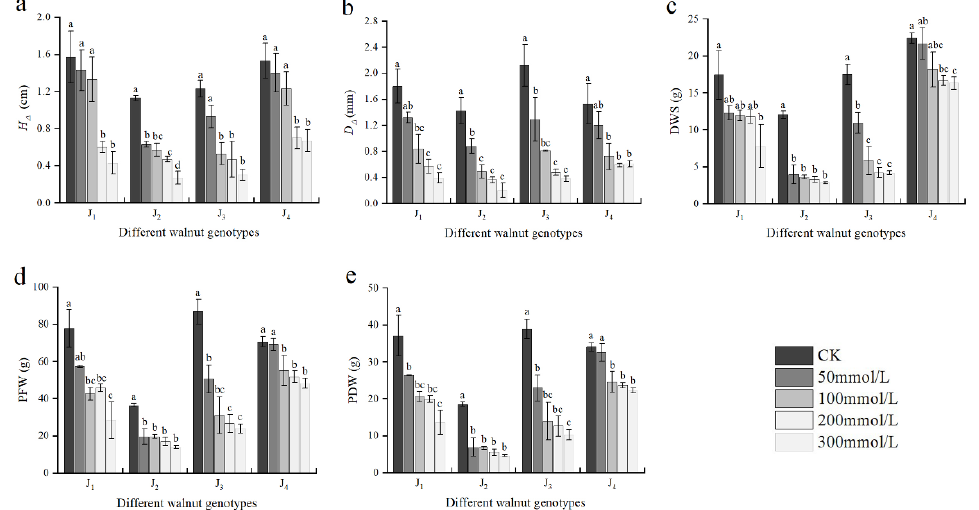
Figure 2. Effect of salt stress on the growth of walnut. ( a ) Seedling height increment ( H ∆ ), ( b ) ground diameter increment ( D ∆ ), ( c ) dry weight of shoot (DWS), ( d ) plant fresh weight (PFW), and ( e ) plant dry weight (PDW). Four walnut genotypes were grown under different NaCl concentrations (0, 50, 100, 200, and 300 mmol/L) for 28 days. Each value indicates the mean ± standard error (SE) of three biological replicates. Bars of each parameter labeled with different letters are significantly different ( p < 0.05) by Duncan’s test. Table 2. Main and interactive effects of genotype and salinity on growth, and physiological and biochemical parameters of walnut.